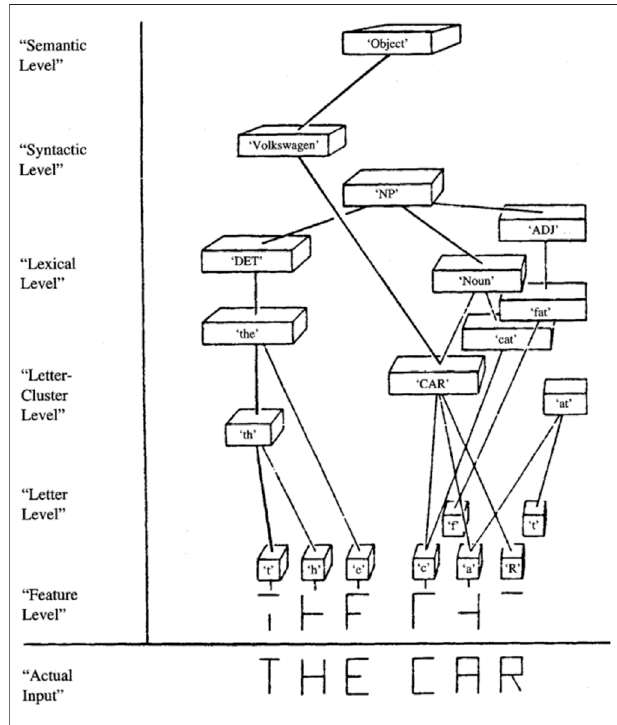
FIGURE 1 | (Rumelhart, 1994) Message Center near the end of processing when the semantics of the imput have been well de fi ned.